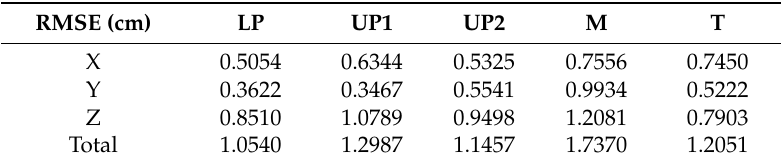
Table 4. Comparison of accuracies for each LED position.